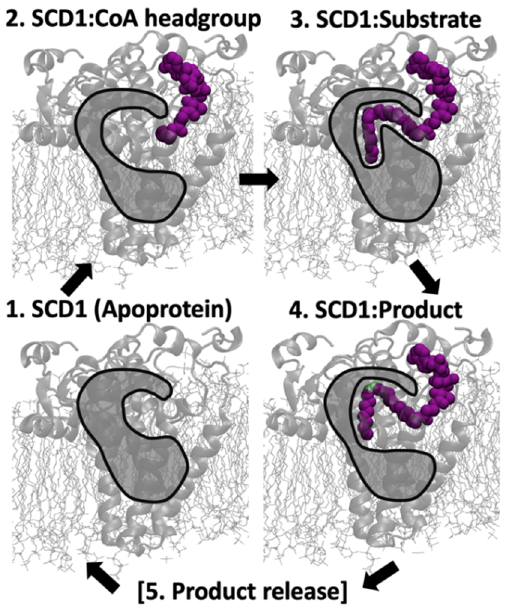
Scheme 1. Proposed sequence of binding events. SCD1 appears in the membrane, with the hydrophobic tunnel represented by an opaque gray shape with black outline with purple ligand, desaturated carbons in green.